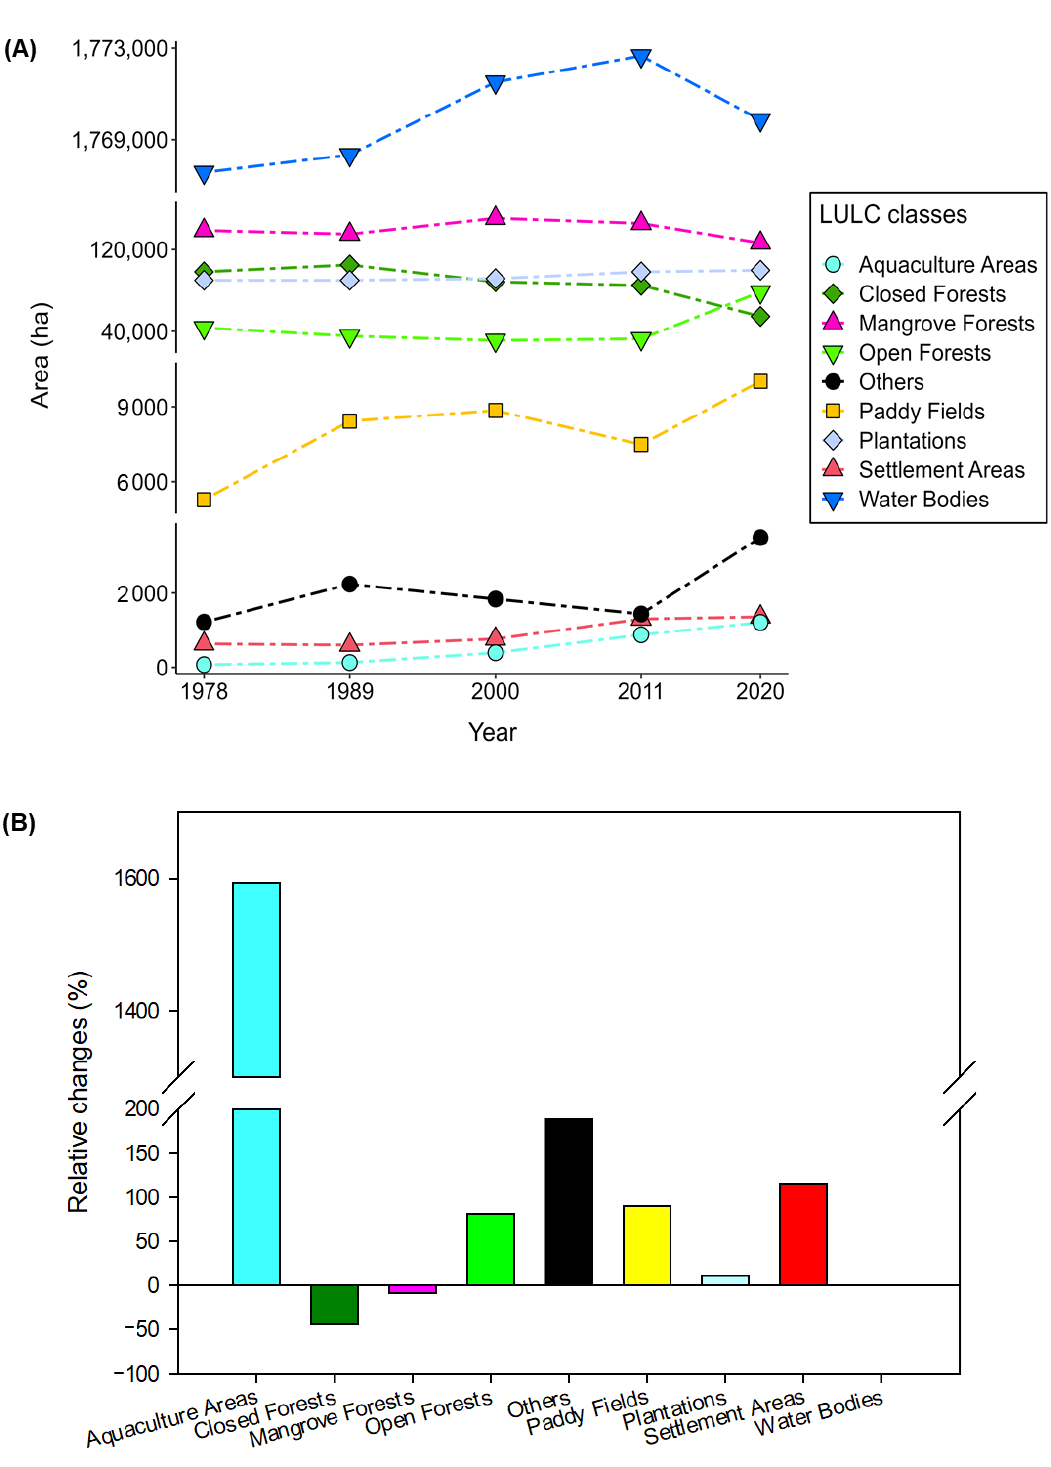
Figure 5. ( A ) Trends of the change in and ( B ) relative changes in LULC classes of Kyunsu township of Southern Myanmar across the last 40 years.